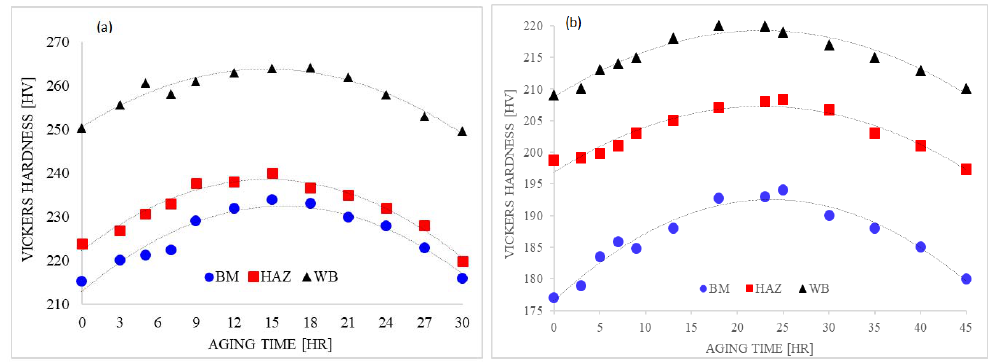
Figure 6. Hardness measurements in the weldments of ( a ) API X60 and ( b ) API X65.